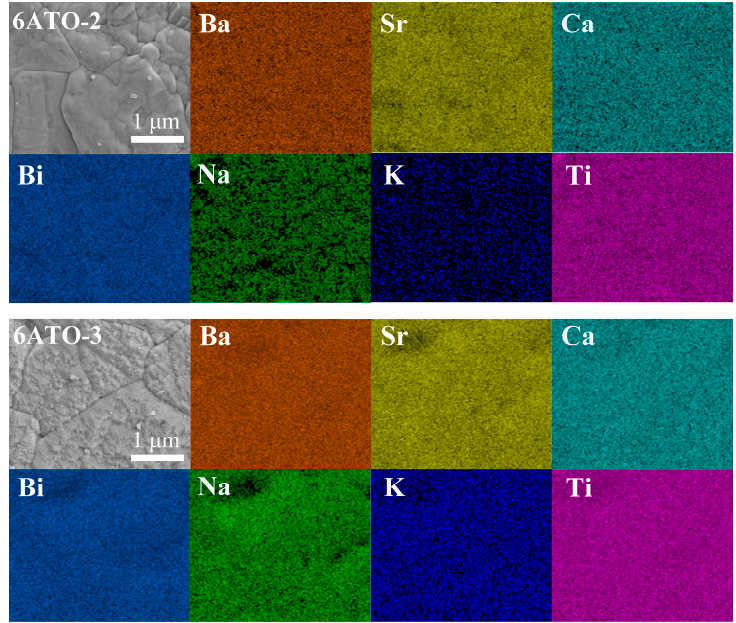
Figure 3. SEM images and corresponding EDS sample mapping of 6ATO-2 and 6ATO-3.